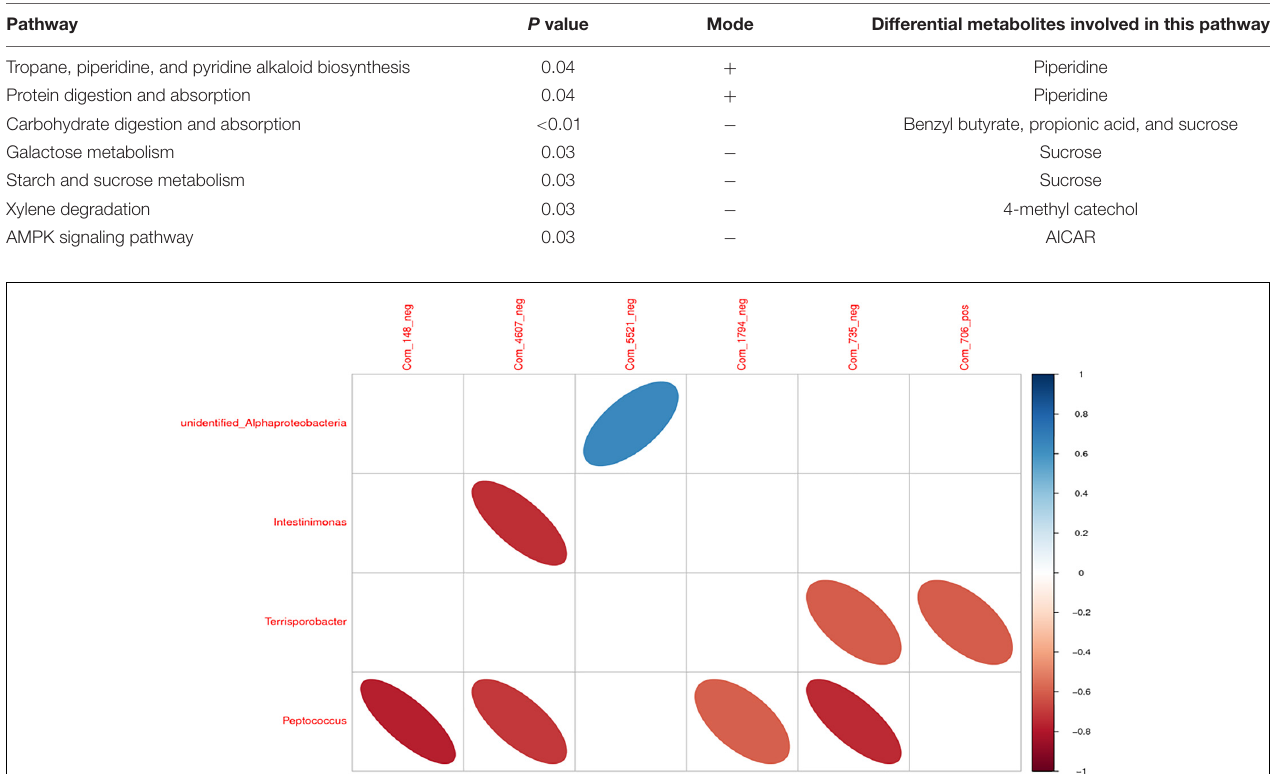
TABLE 5 | The significant difference of the Kyoto Encyclopedia of Genes and Genomes (KEGG) enrichment table of the positive and negative ion modes.